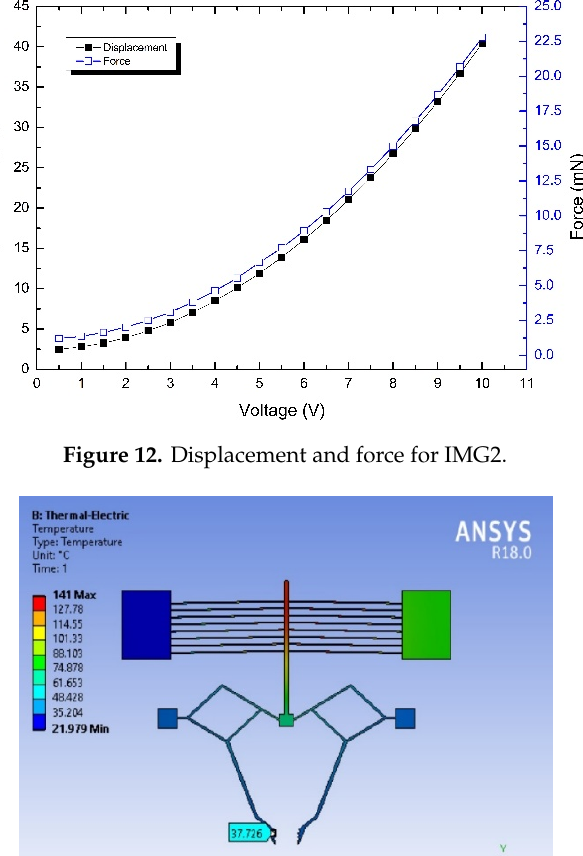
Figure 13. Temperature distribution of IMG2.